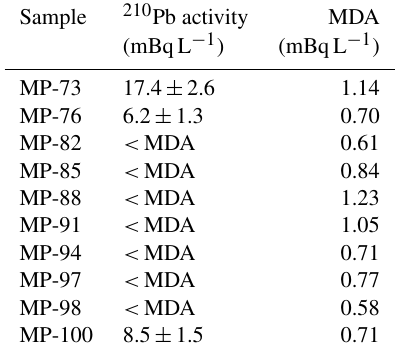
Table 2. Determination of 210 Pb activity in the soluble water frac- tion of 100g of ice from Monte Perdido samples. MDA: minimum detection